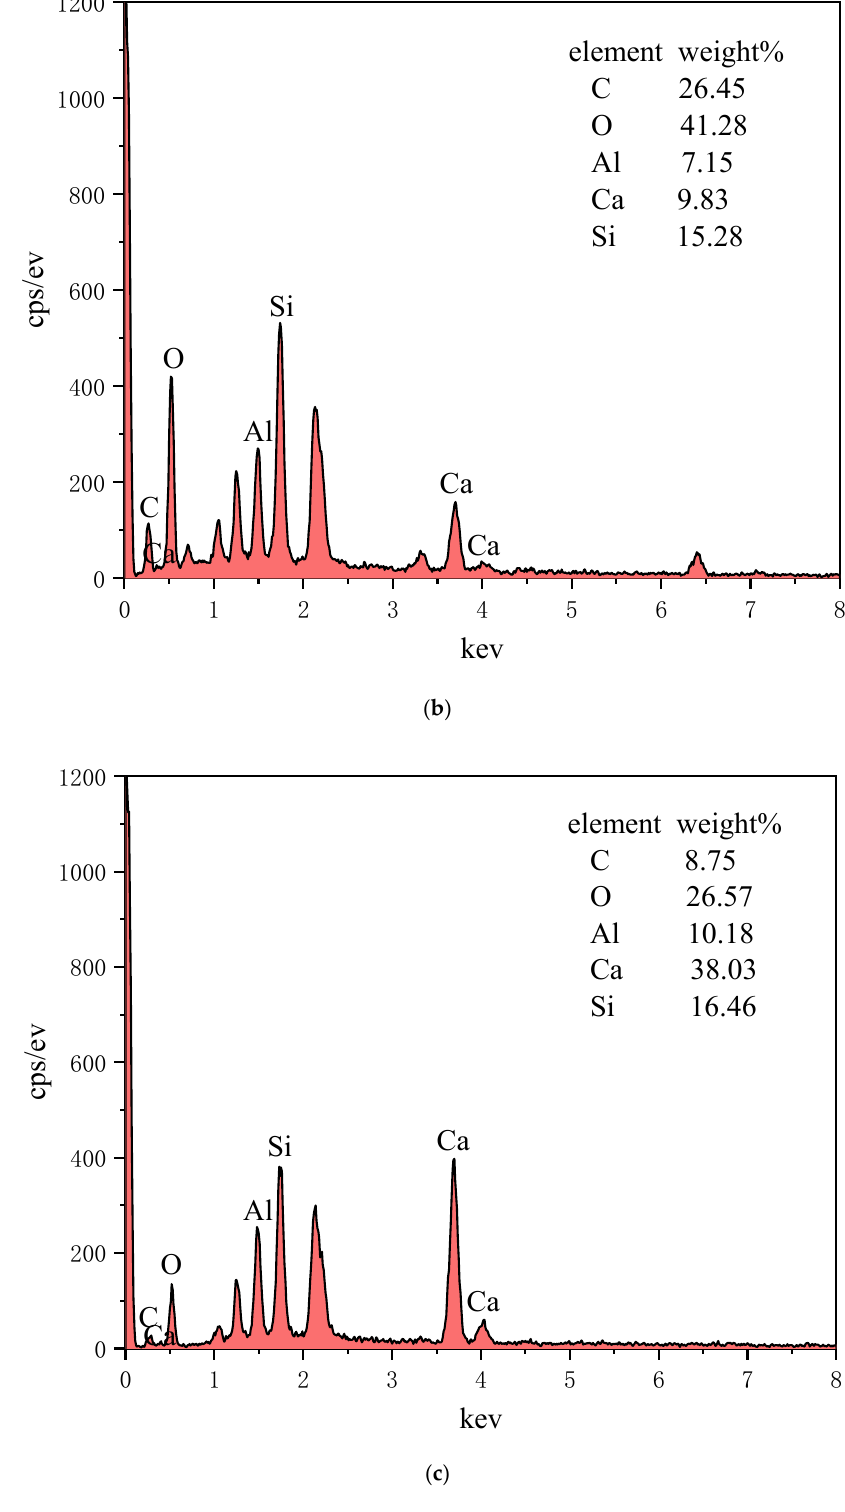
Figure 7. RHA3 microgram. ( a ) Micromorphology of RHA3. ( b ) Upper arrow in figure. ( c ) Lower arrow in figure.